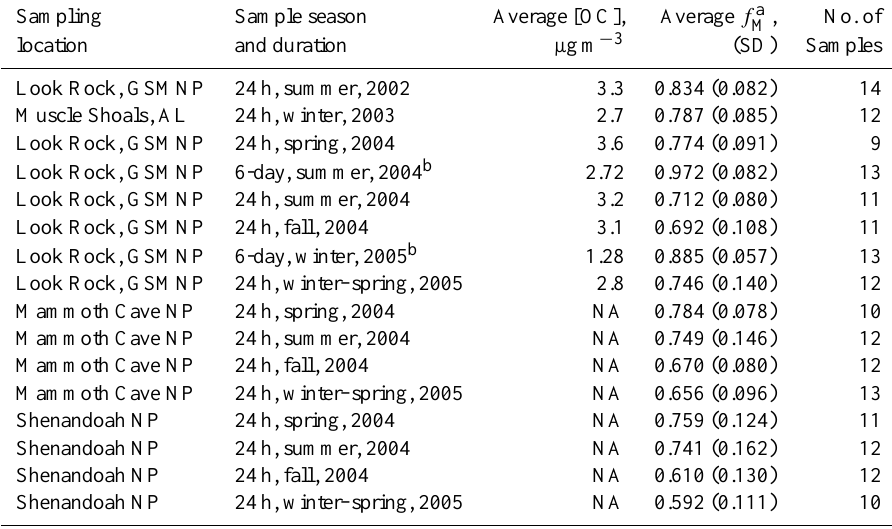
Table 4. Summary of 14 C data for aerosol carbon in PM 2 . 5 samples from Look Rock and other non-urban southeastern US sites, 2002–2005. Sampling